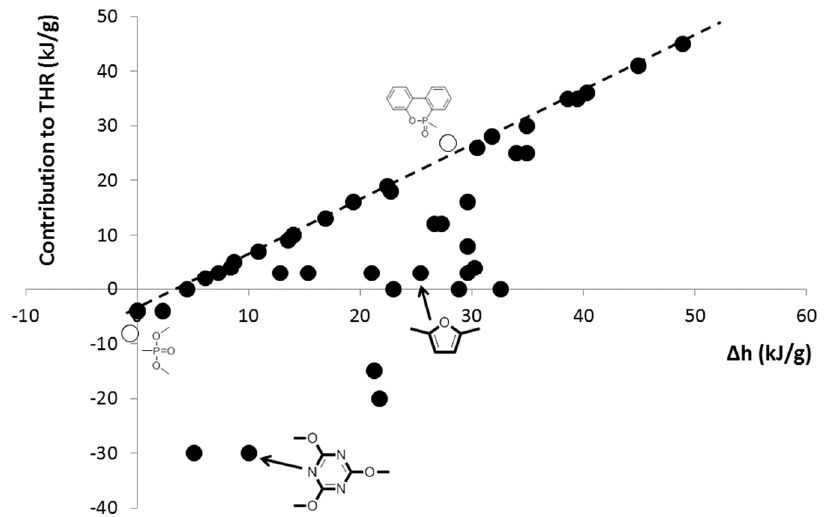
Figure 7. Contribution to THR versus ∆ h calculated from the Huggett relation for 47 groups.